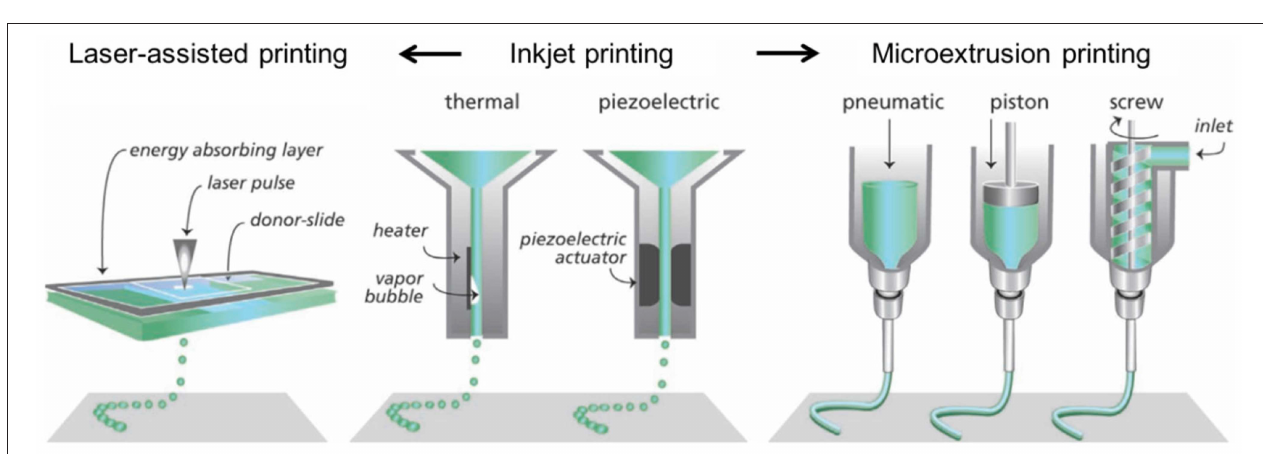
FIGURE 2 | Common additive manufacturing methods for printing of complex constructs. Adapted from Malda et al. (2013) with permission from WILEY-VCH Verlag GmbH & Co. KGaA,